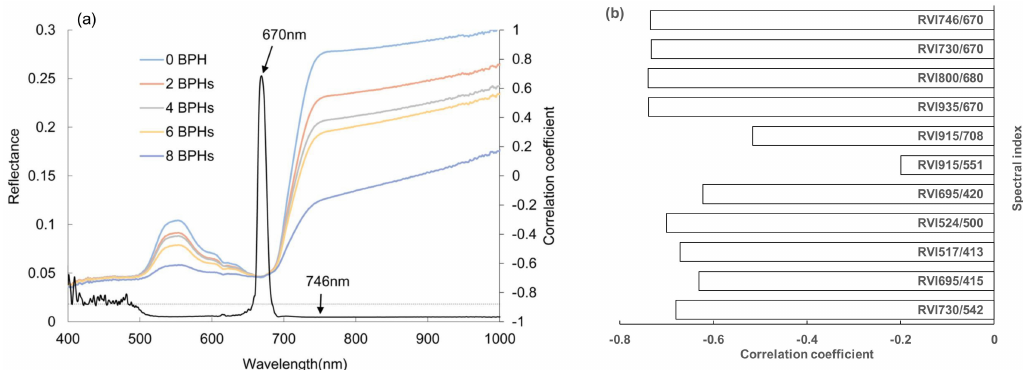
Figure 2. Reflectance from a rice plant exposed to 0–8 BPH nymphs for six days and the correlation coefficients (the black curve) between reflectance in each 1 nm wavelength from 400 to 1000 nm and the number of BPH ( a ), and the correlation between the ratio vegetation index and the number of BPH ( b ). The horizontal dash line in ( a ) represents the significant level of the correlation coefficient at p =